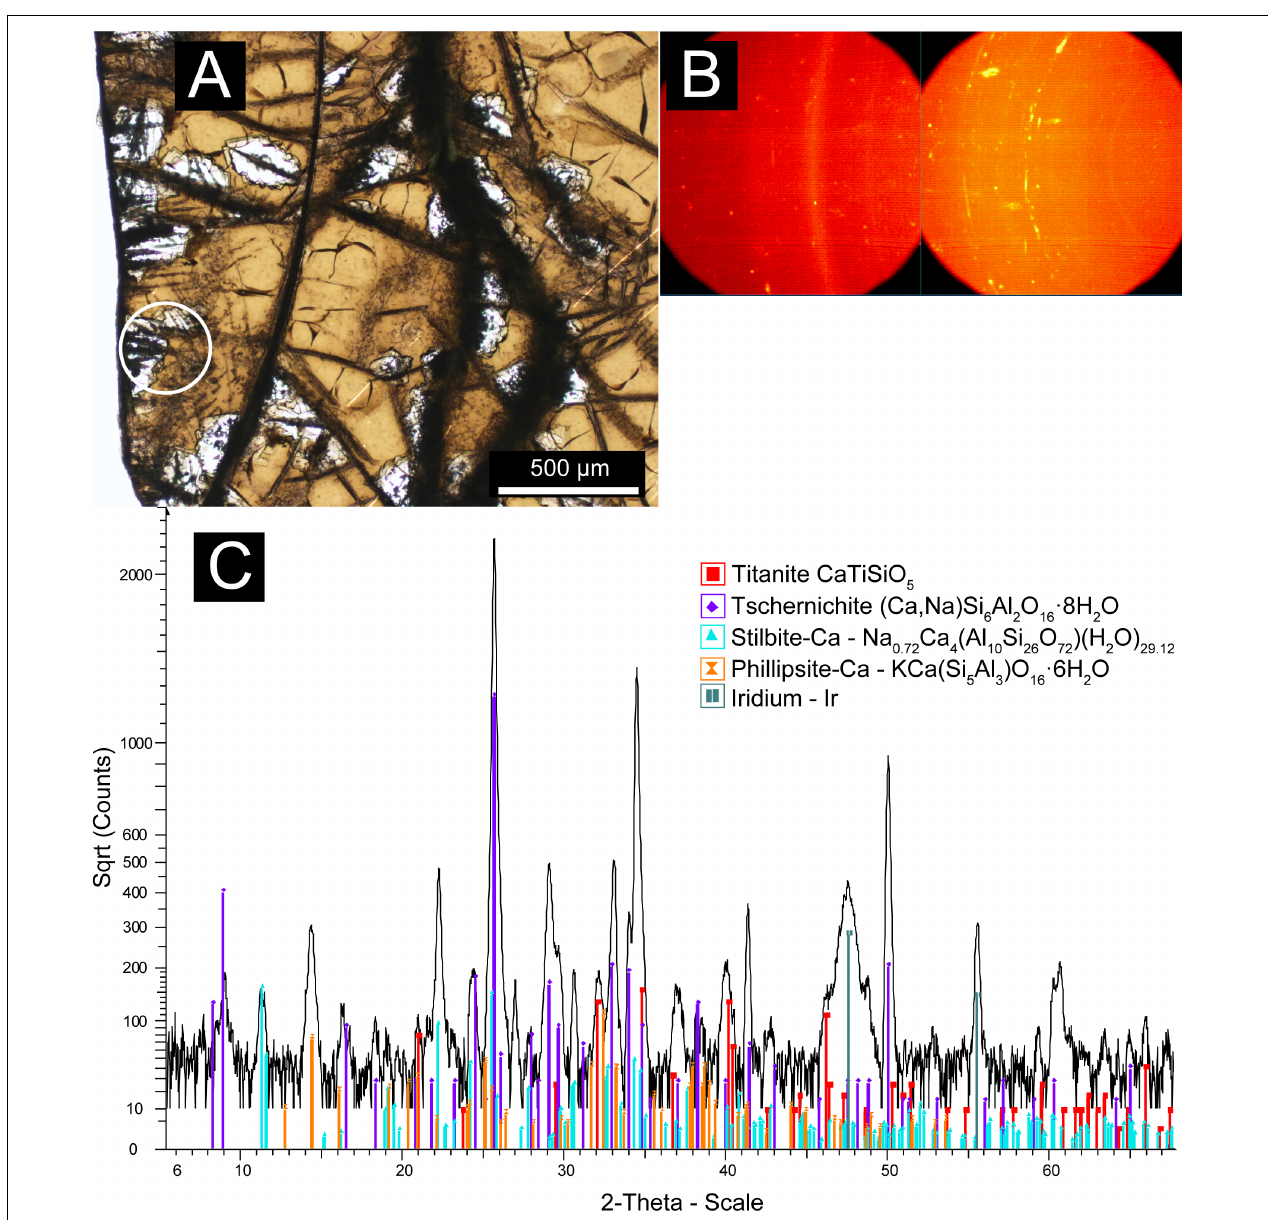
FIGURE 4 | Micro XRD data showing the mineralogy of the zeolite alteration zone hosting titanite-mineralized tubules. (A) Transmitted plane-polarized light (PPL) photomicrograph with the nominal 300 µ m beam in area analyzed footprint marked by the white circle. (B) General Area Detector Diffraction System (GADDS) images showing distribution of diffracted X-ray intensity. Discontinuous “spotty” Debye rings correspond to zeolites, whilst continuous rings correspond to fine-grained titanite and the iridium layer deposited for electron beam analysis. (C) Integrated, background-subtracted diffractogram with International Center for Diffraction Data (ICDD) pattern matches to: tschernichite (Ca, Na)Si 6 Al 2 O 16 · 8H 2 O (046-1396), Titanite CaTiSiO 5 (050-1614), Stilbite-Ca Na 0 . 72 Ca 4 (Al 10 Si 26 O 72 ) (H 2 O) 29 . 12 (079-1676), Phillipsite-Ca – KCa(Si 5 Al 3 )O 16 · 6H 2 O (039-1375), iridium coating